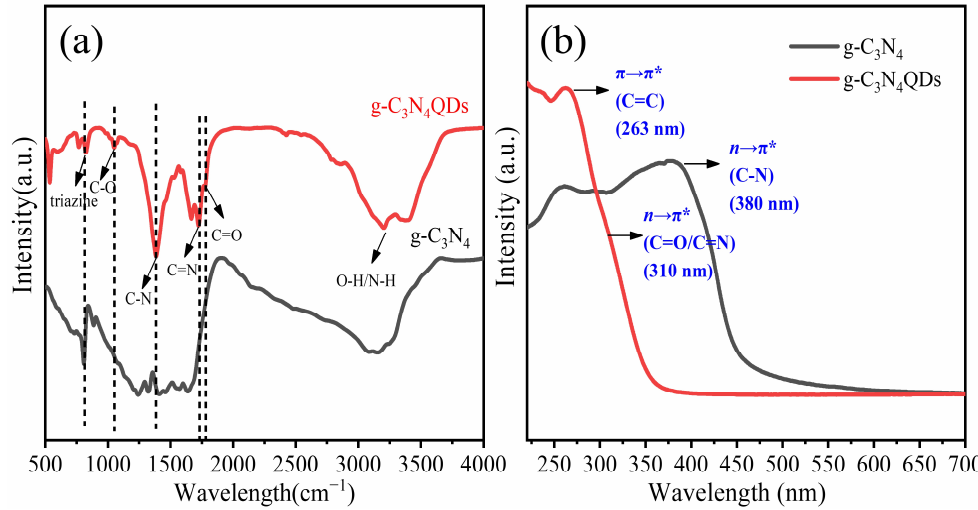
Figure 3. FT-IR spectra of ( a ) and UV-vis absorption spectra of ( b ) of g-C 3 N 4 and g-C 3 N 4 QDs.